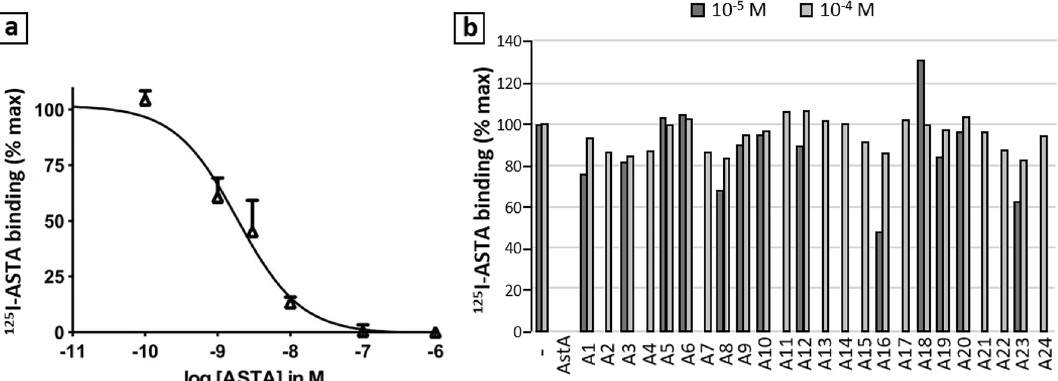
Figure 2. In vitro competitive binding assays for the A-series molecules. ( a ) Competition curve for the native ligand ASTA on HEK cells. ( b ) Results (% max) obtained with the 24 tested A molecules (positive control: ASTA 10 -6 M). Only A8, A16 and A23 showed dose-dependent binding (3 replicates).